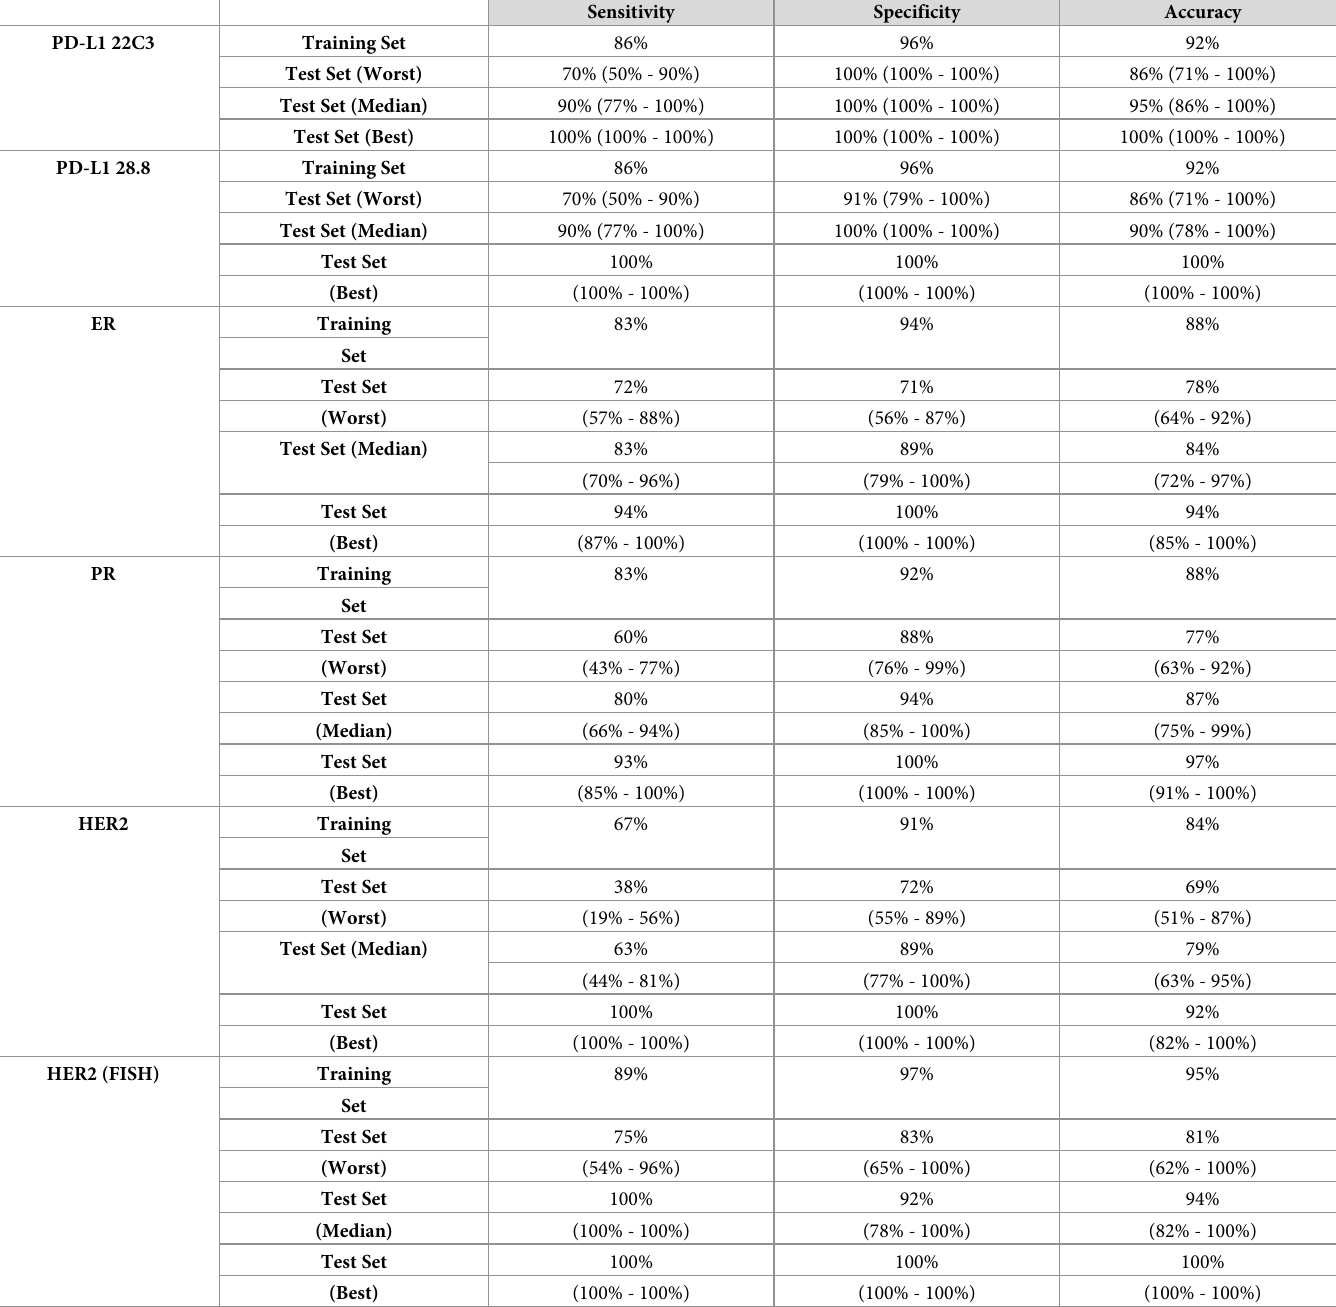
Table 2. Clinical performance characteristics. The table provides the performance characteristics of the Test which were determined from 20 iterations of the Test Set and the Best-, Median- and Worst-Case values are